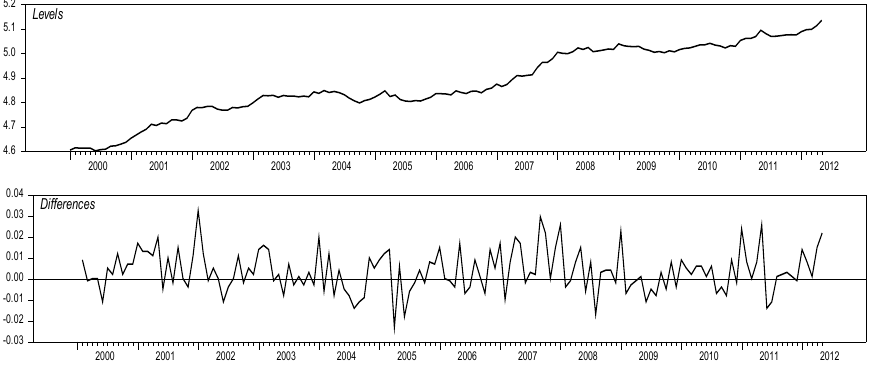
Figure 4. Logarithmic Slovenian food and beverages price index. Data vector January 2000 to May 2012 (Great Depression).